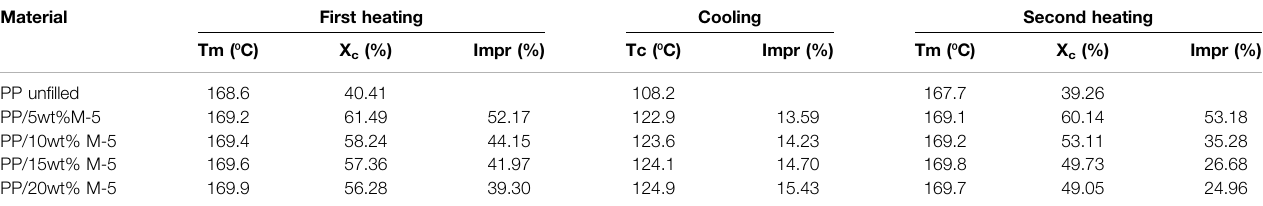
TABLE 3 | Effect of GNP addition on the thermal properties of un fi lled PP and PP/GNP composites. Material First heating Cooling